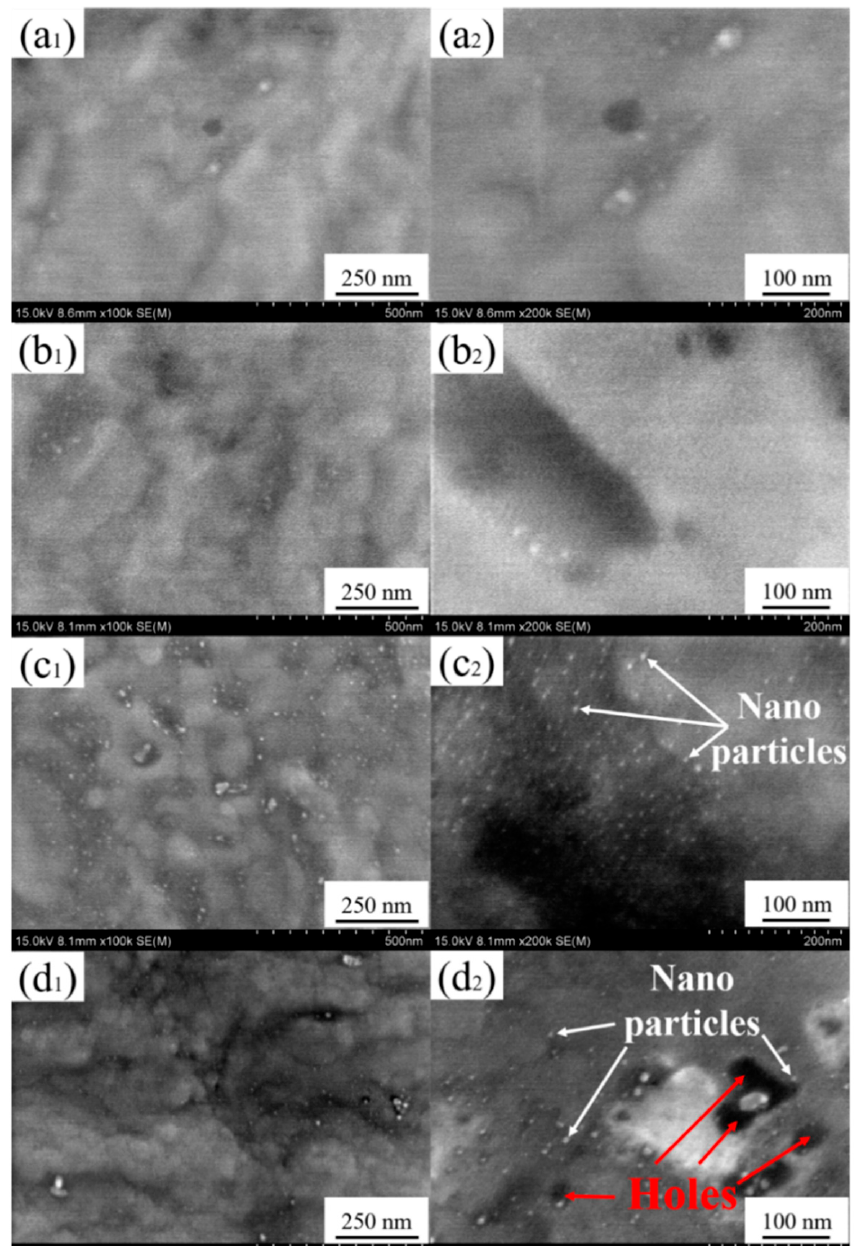
Figure 2. The surface morphologies of TiNb alloy implanted by different doses of silver ions: ( a 1, a 2 ) Ag-1 × 10 16 ions/cm 2 , ( b 1, b 2 ) Ag-5 × 10 16 ions/cm 2 , ( c 1, c 2 ) Ag-10 × 10 16 ions/cm 2 , and ( d 1, d 2 ) Ag-15 × 10 16 ions/cm 2 .